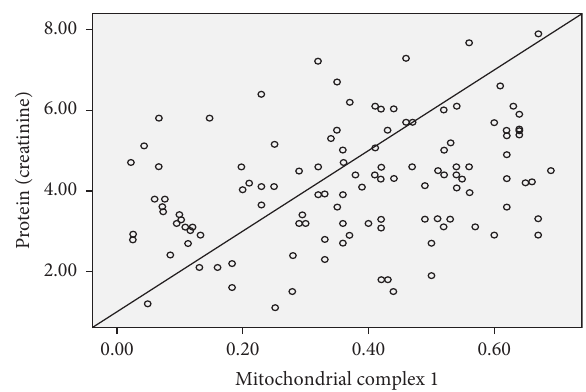
Figure 1: Correlation regression analysis between complex I ac- tivity and severity of proteinuria among the studied